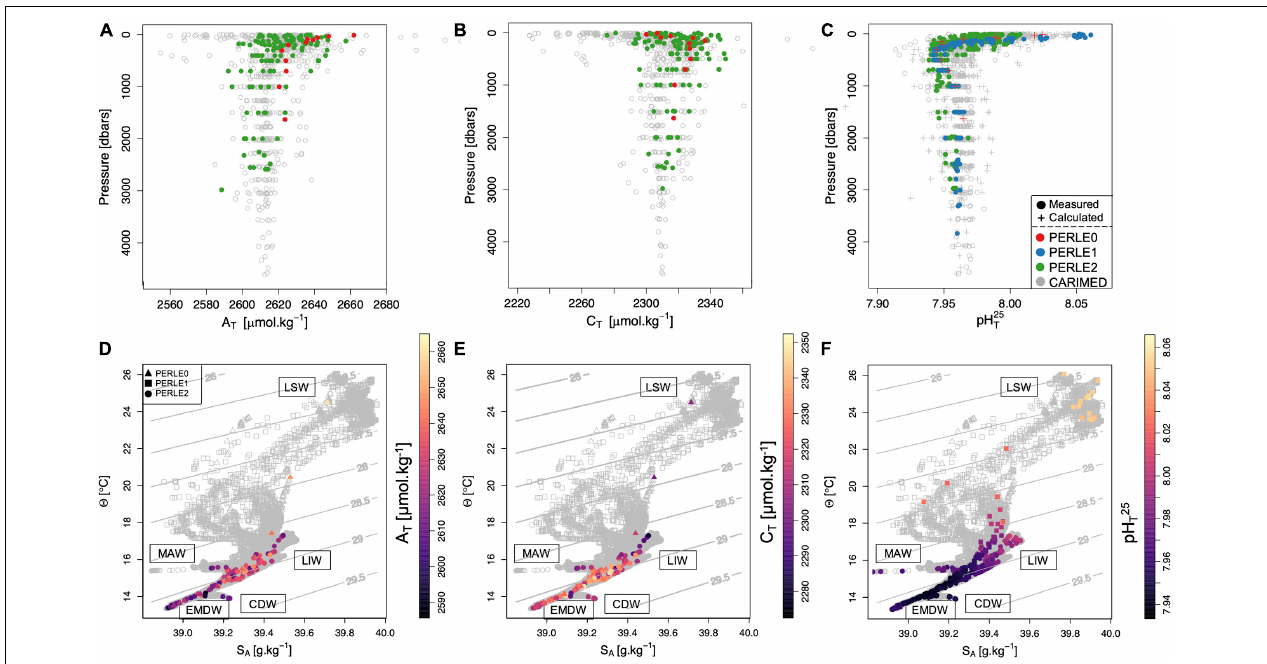
FIGURE 2 | Upper panel: Vertical profiles of total alkalinity (A T – µ mol.kg − 1 ; A ), total dissolved inorganic carbon (C θ – µ mol.kg − 1 ; B ) and pH (measured and calculated) in total scale at 25 ◦ C (pH T 25 ; C ) for the three PERLE cruises superimposed on the CARIMED data corresponding to the PERLE area (22 ◦ –29 ◦ E, 33 ◦ –36.5 ◦ N; grey dots). Lower panel: (cid:50) –S A diagrams for the three PERLE cruises with the name of the main water mass end members for the entire water column. Colored points correspond to A T on (D) , to C T on (E) and to pH T 25 on (F) . Isopycnal horizons based on potential density referenced to a pressure of 0 dbar ( σ θ ) are represented by grey contour lines. On (D–F) , different dots have been used for each PERLE cruise. Because no A T and C T data were available for PERLE1 cruise, only pH T 25 data have been represented (C,F)